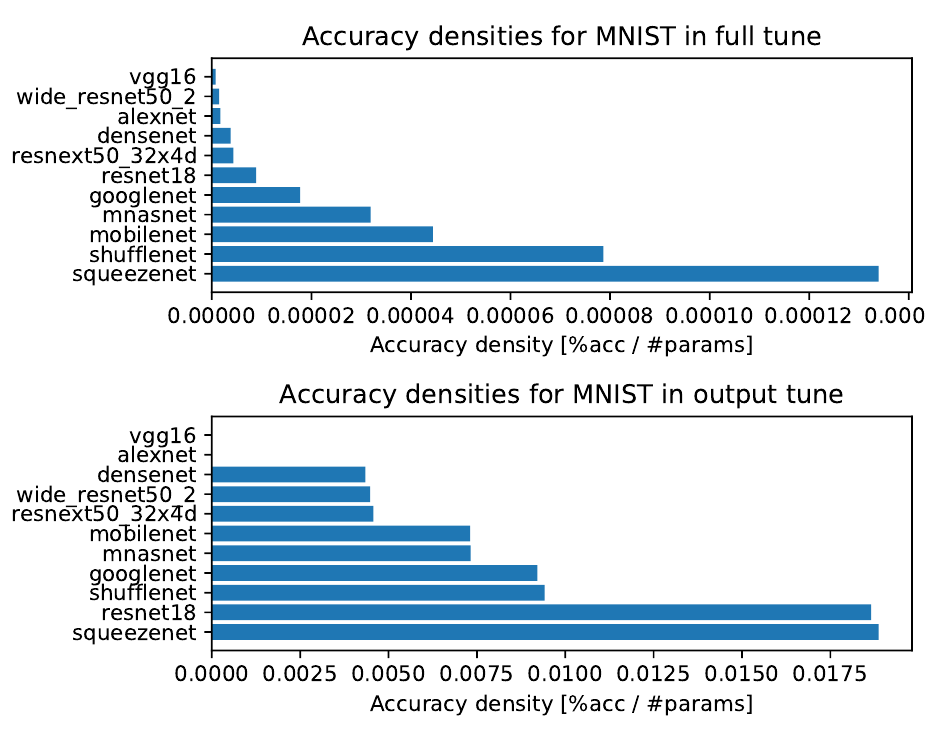
Figure A8. Accuracy densities for ten-episodes learning on